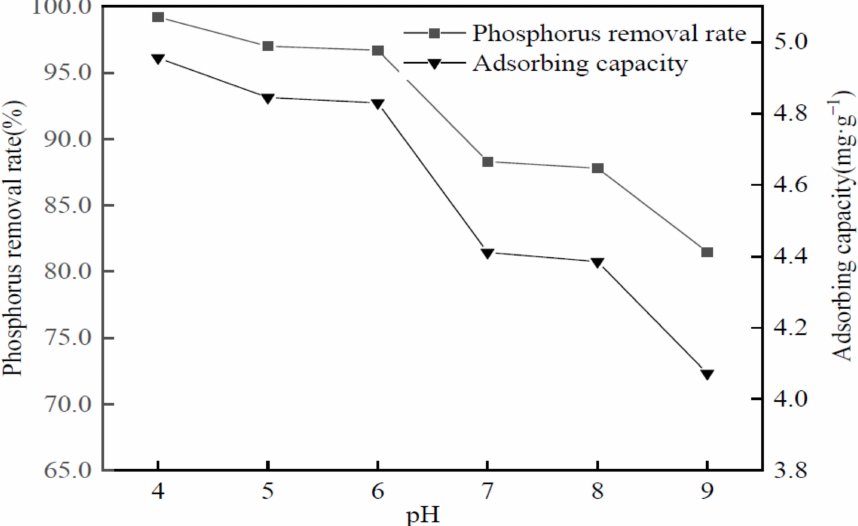
Figure 9. Effect of pH of phosphorus-containing wastewater on phosphorus removal performance.